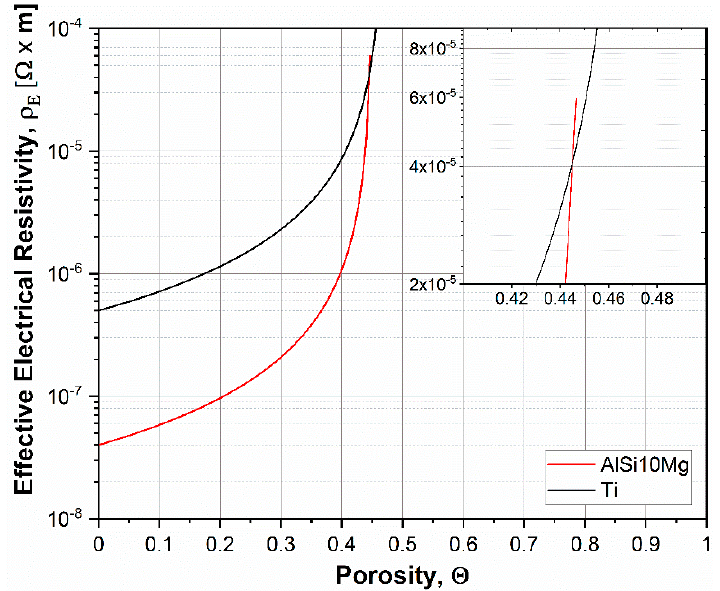
Figure 9. Effective electrical resistivity as calculated for AlSi10Mg and CP-Ti powders.